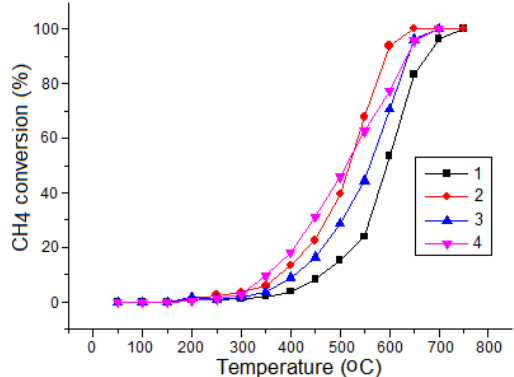
Figure 5. The relative content of methane in the methane–air mixture after reaction on the 10% V/Al 2 O 3 catalyst at different temperatures: 1—heating of the catalyst in air for 1 h at 300 °C; 2—at 600 °C for 1 h; 3—at 700 °C for 1 h; 4—sample additionally heated at 600 ° С for 1 h after all meas- 2—at 600 ◦ C for 1 h; 3—at 700 ◦ C for 1 h; 4—sample additionally heated at 600 ◦ C for 1 h after all urements.